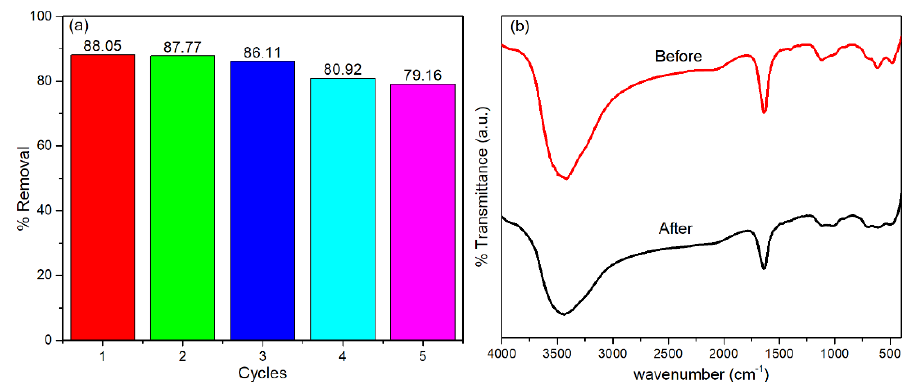
Figure 10. ( a ) Reusability studies of Fenton degradation of OFL using FeZ-8. ( b ) FTIR spectra of FeZ- 8 catalyst before and after the Fenton degradation of OFL.